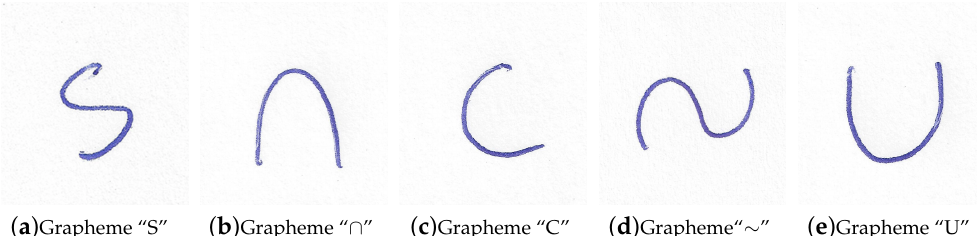
Figure 1. Simple grapheme